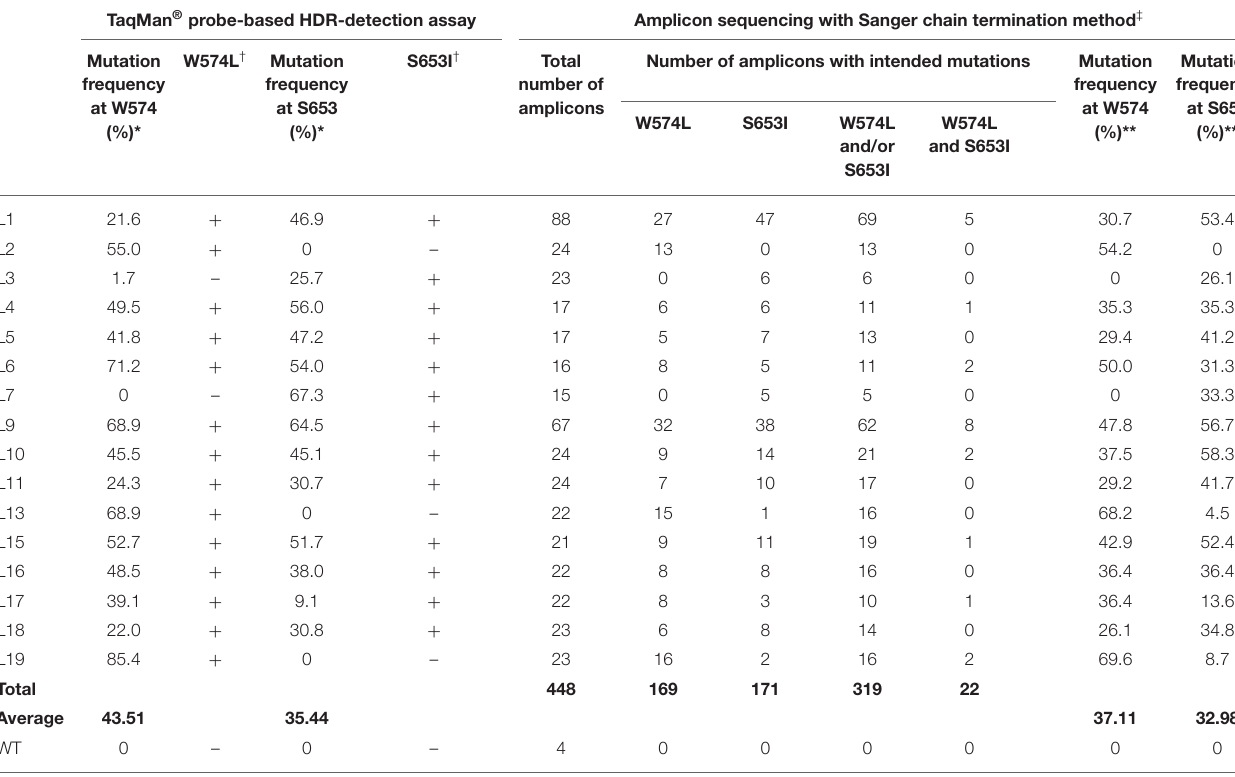
TABLE 2 | Edited sugarcane lines with intended mutations W574L and